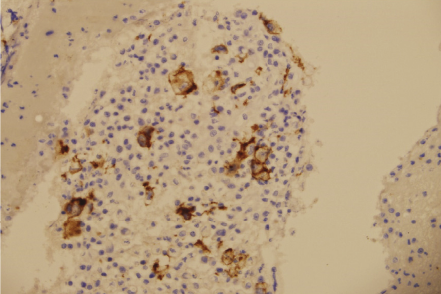
Figure 5: Right paratracheal lymph node EBUS-TBNA biopsy stained positive for CD30 immunochemistry ( ×